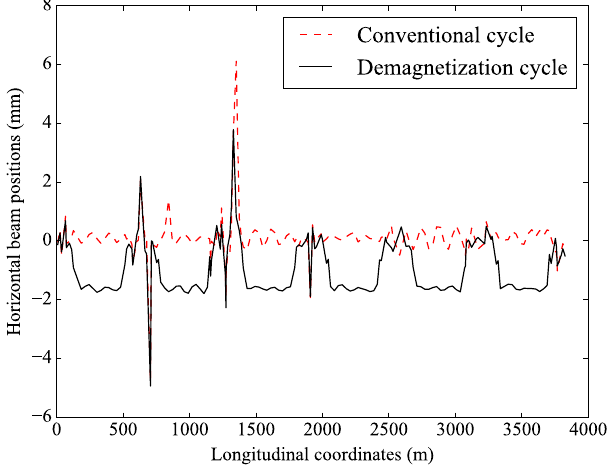
FIG. 8. Comparison of the horizontal average beam position drifts, due to persistent currents decay in superconducting di- poles, with the conventional cycle (the blue curve) and the demagnetization cycle (the green curve).